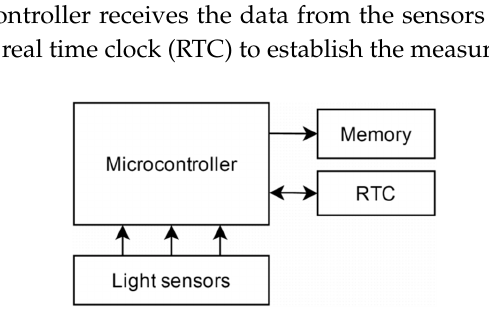
Figure 2. Basic electronic schema.